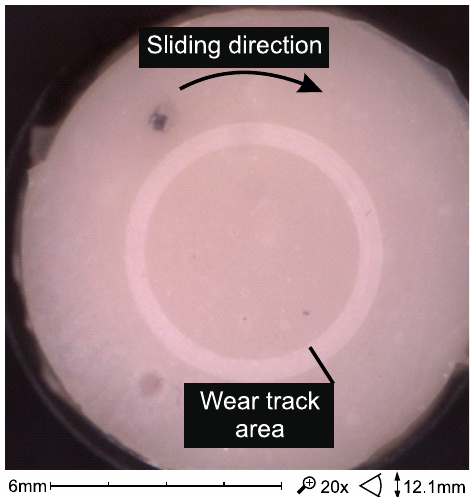
Figure 7. SEM micrographs of wear trace after sliding test against alumina ball in artificial saliva in 37 ◦ C (Ex-flow(P) composite).